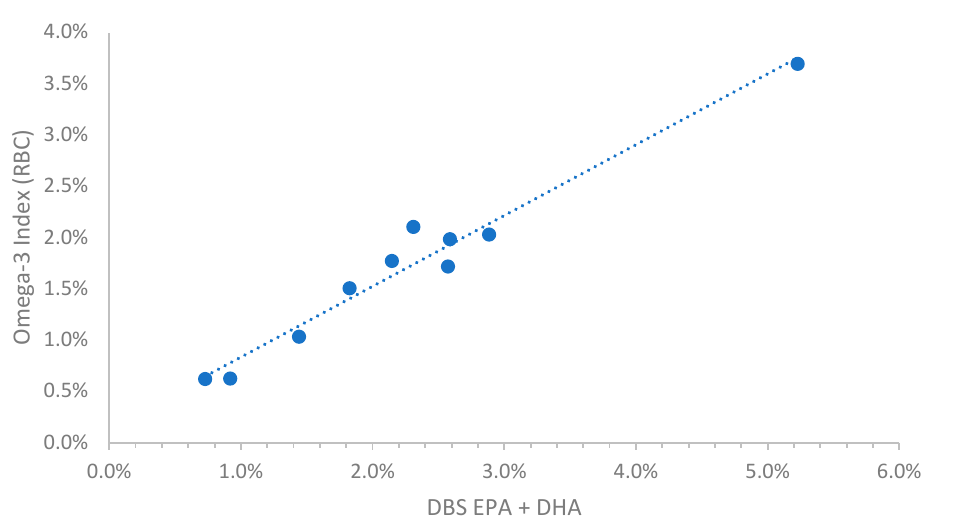
Figure 2. Relationship between the EPA + DHA content of DBS samples and the Omega-3 Index in 10 cats. DBS, dried blood spot; RBC, red blood cell.